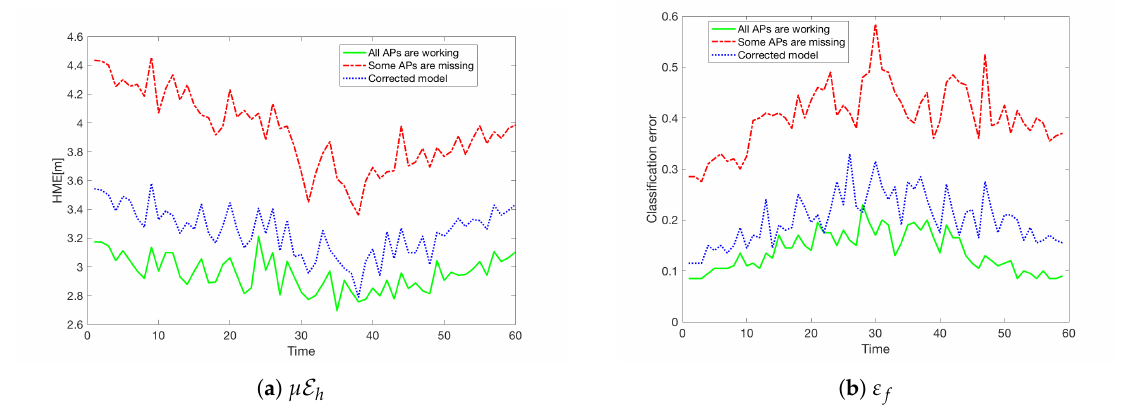
Figure 12. The results after the model was updated ( K =